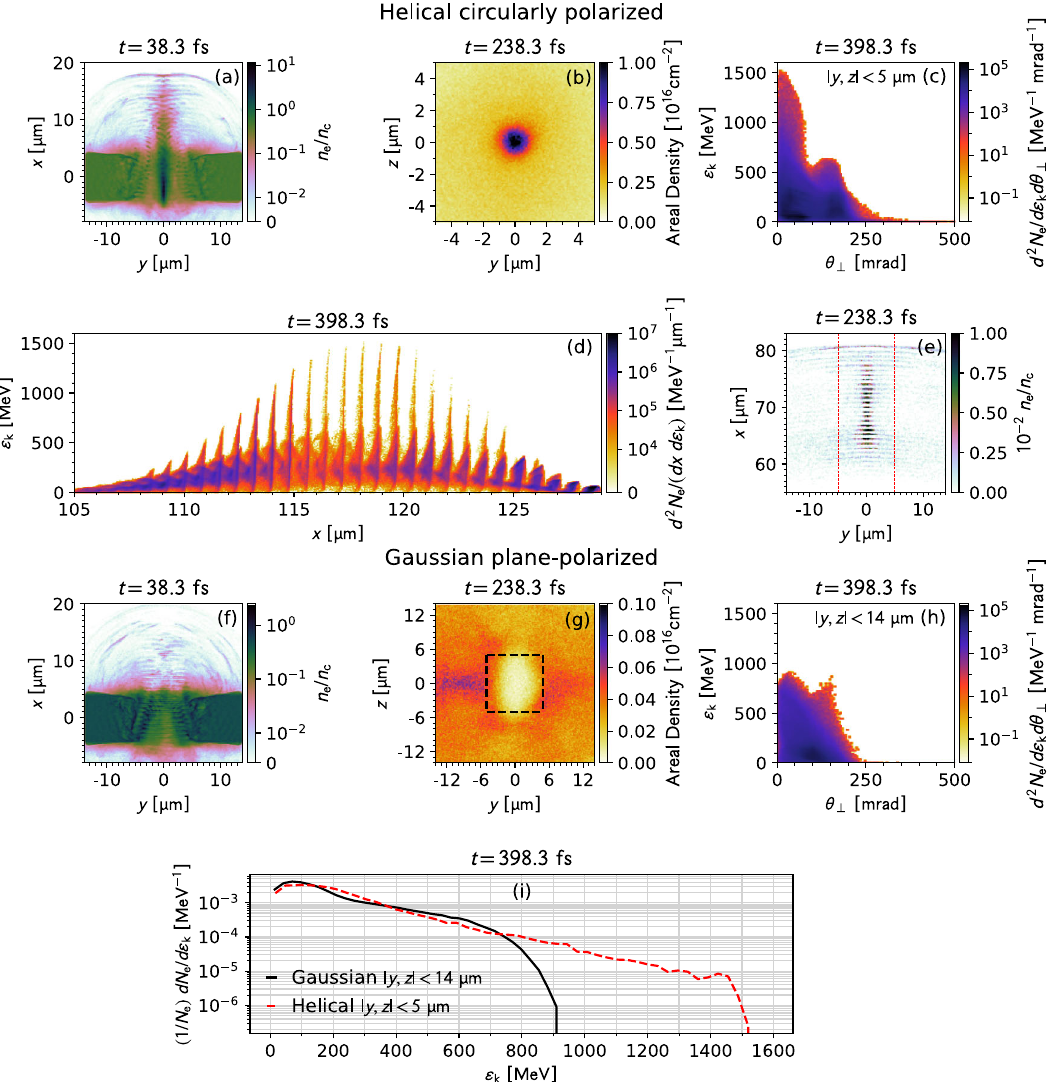
Fig. 4 Optimal regime of electron acceleration at normal incidence and comparison with a plane-polarized Gaussian beam. a – e Electron data from a simulation where a target with n max ¼ 0 : 5 n c is irradiated by the helical beam. f – h Electron data from a simulation where the same target is irradiated by a plane-polarized Gaussian beam that has the same peak power of 3 PW. a , f Electron density n e normalized to the critical density n c during laser pulse transmission. b , g Areal density at t = 238.3 fs calculated by integrating n e along x . e Density of electrons accelerated by the helical beam at t = 238.3 fs. The vertical dashed lines mark the region shown in ( b ). c , h Electron energy distribution at t = 398.3 fs for different divergence angles q(cid:5) (cid:6) ffiffiffiffiffiffiffiffiffiffiffiffiffiffiffi θ ¼ tan (cid:3) 1 p = p 2 þ p 2 . The distribution in ( c ) is calculated for ∣ y , z ∣≤ 5 μ m, whereas the distribution in ( h ) is calculated for ∣ y , z ∣≤ 14 μ m. d Electron ? x y z energy distribution along the x -axis at t = 398.3 fs for the case with the helical beam, where ε k is the kinetic energy. Only the electrons with ∣ y , z ∣≤ 5 μ m are shown. i Electron spectra ( t = 398.3 fs), where the red curve shows electrons with ∣ y , z ∣≤ 5 μ m in the simulation with the helical beam and the black curve shows electrons with ∣ y , z ∣≤ 14 μ m in the simulation with the Gaussian